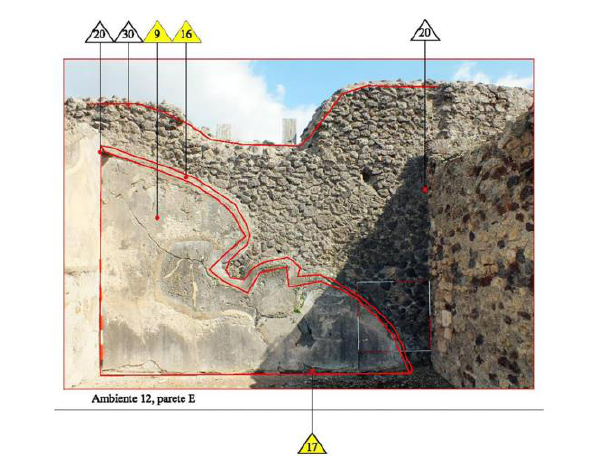
Figure 5. illustrative photo of mapping on a straightened